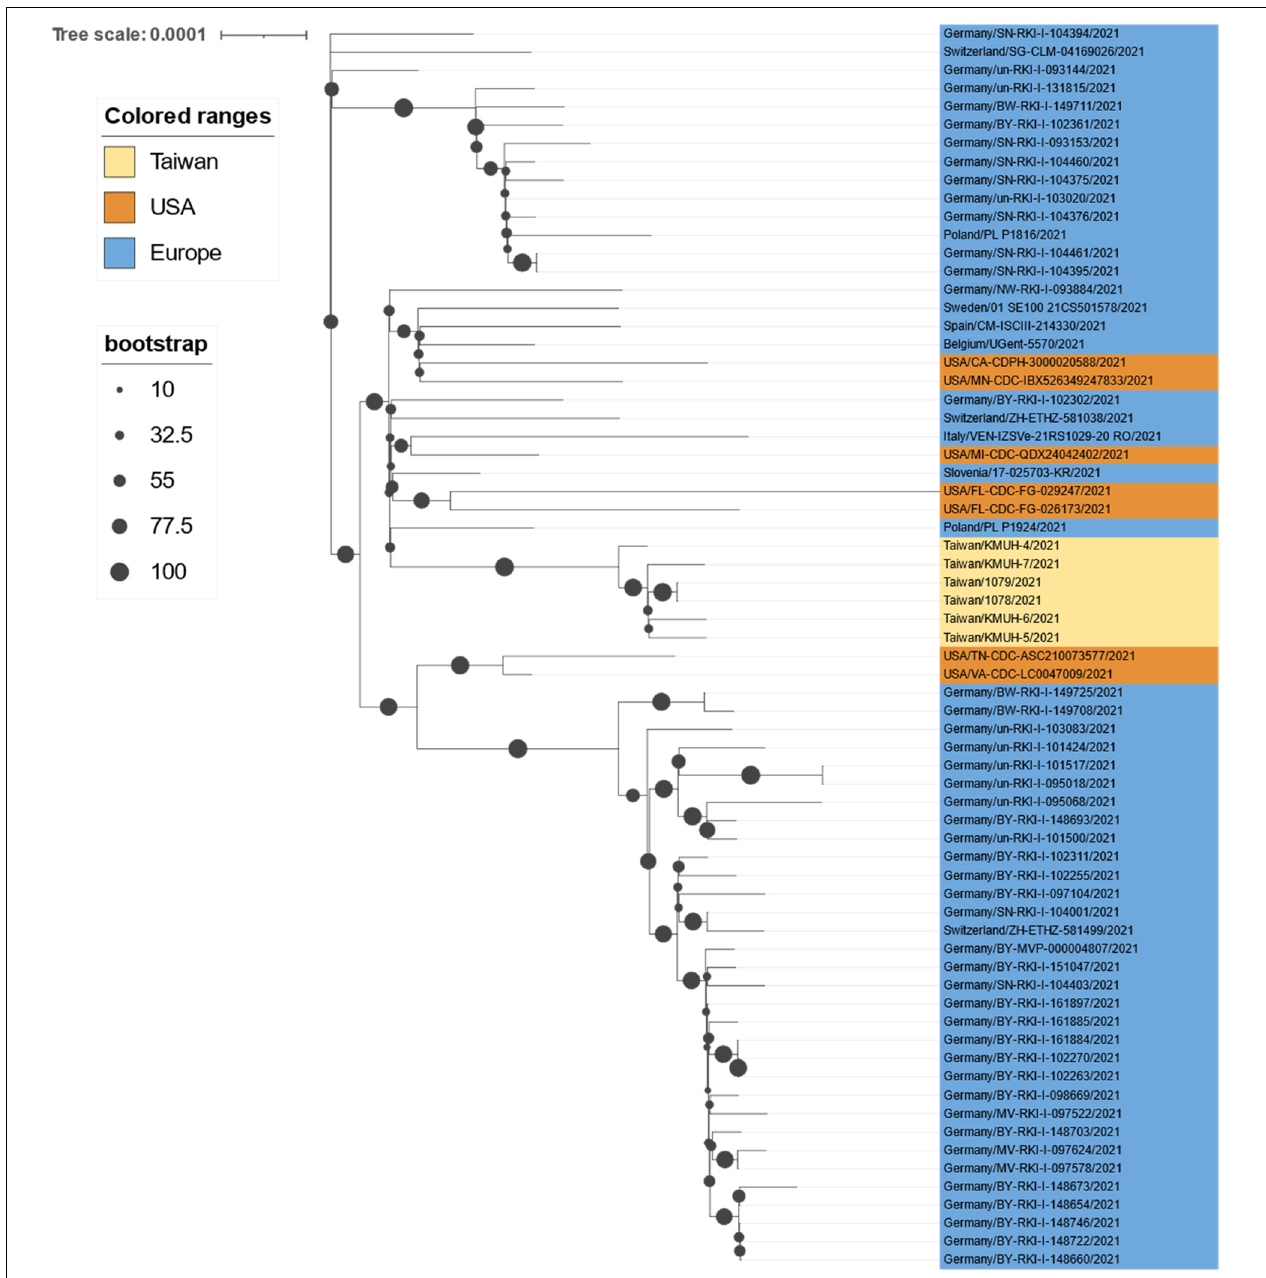
FIGURE 7 | Phylogenetic analysis results of cases 1078/1079, KMUH-4 to KMUH-7, and 62 alpha/B.1.1.7 sequences with D614G and M1237I mutations deposited in GISAID from samples collected between 14 April 2021 and 16 April 2021. The phylogenetic analysis was inferred by using the maximum likelihood and fits of 286 different nucleotide substitution models, and the results suggested TN + F + I as the best-fitting model with the lowest BIC scores of 86,786.332 among the 286 models tested. The tree topology was automatically computed to estimate the maximum likelihood values. The optimal log-likelihood for this computation was –42,677.481. There was a total of 29,662 positions in the final dataset. The original tree is displayed using iTOL v 6.4.3 (https://itol.embl.de/) (73) with an indicator of bootstrap values and a scale bar. Viruses are shown as the virus